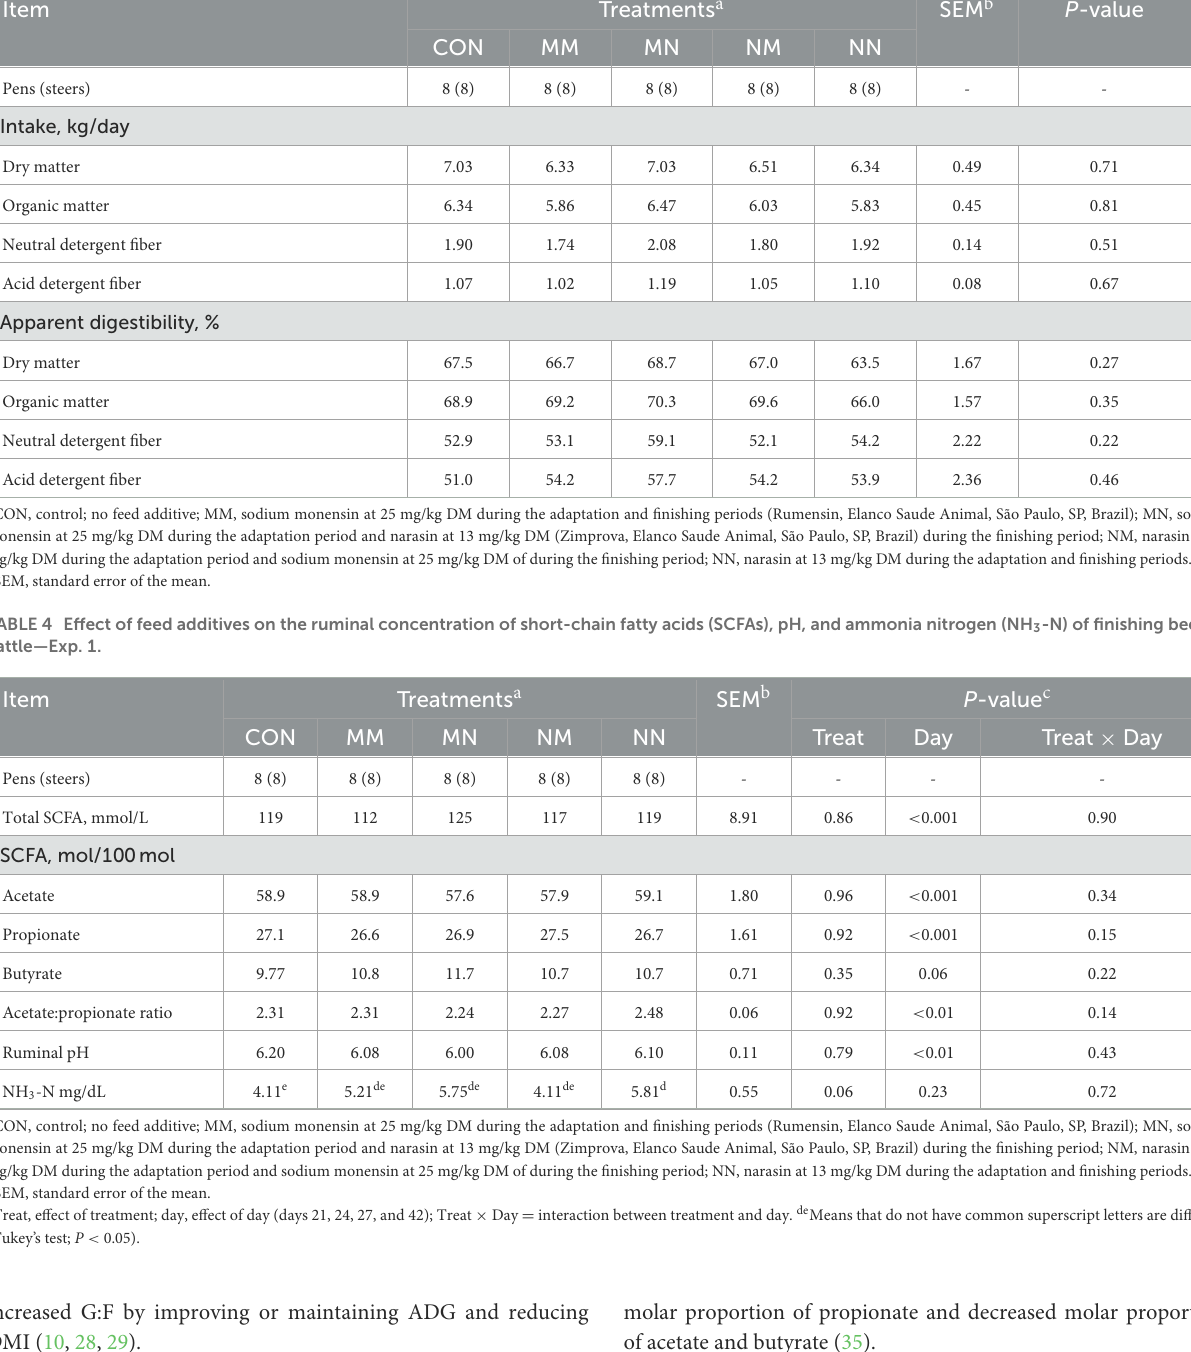
TABLE 3 Effect of feed additives on intake and apparent digestibility of nutrients of finishing beef cattle—Exp. 1; days 37–42. Item